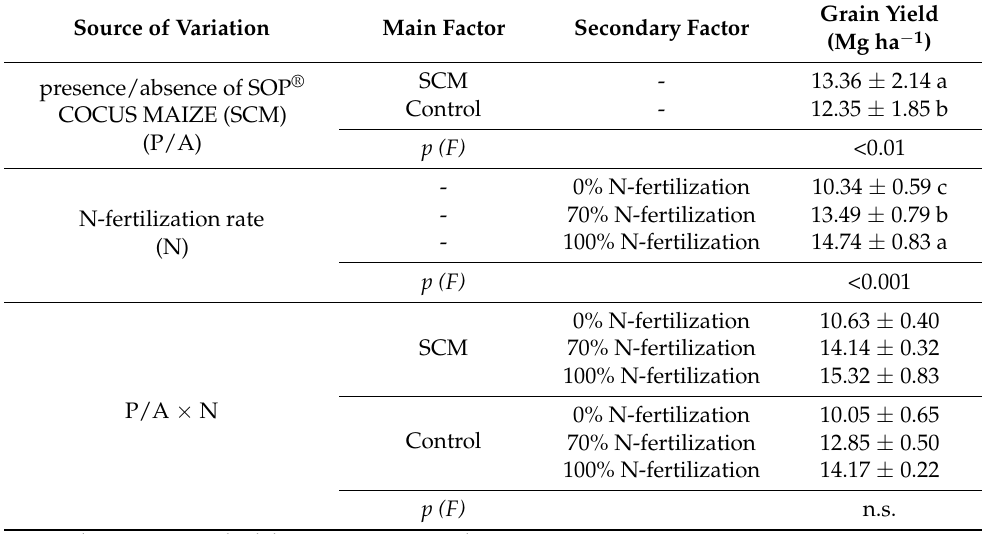
Table 1. Grain yield (Mg ha − 1 ) of maize as affected by the presence/absence of SCM (SCM vs control) and N-fertilization rate (0%, 70%, and 100% N-fertilization). Different letters within the same source of variation indicate statistical significant differences between means.